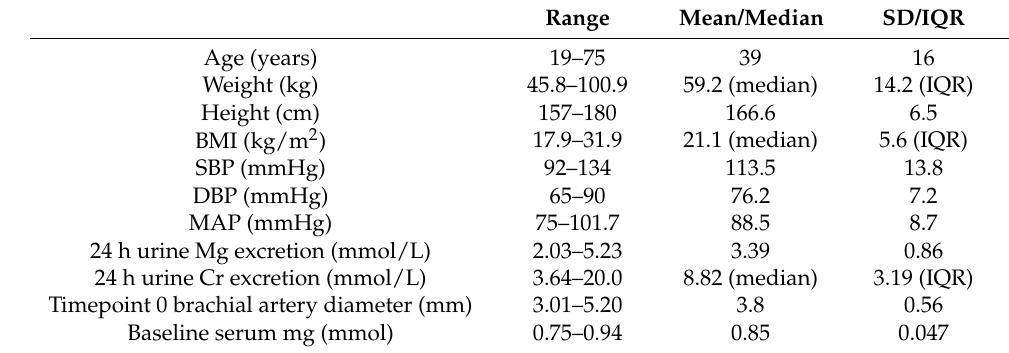
Table 1. Baseline characteristics ( n =